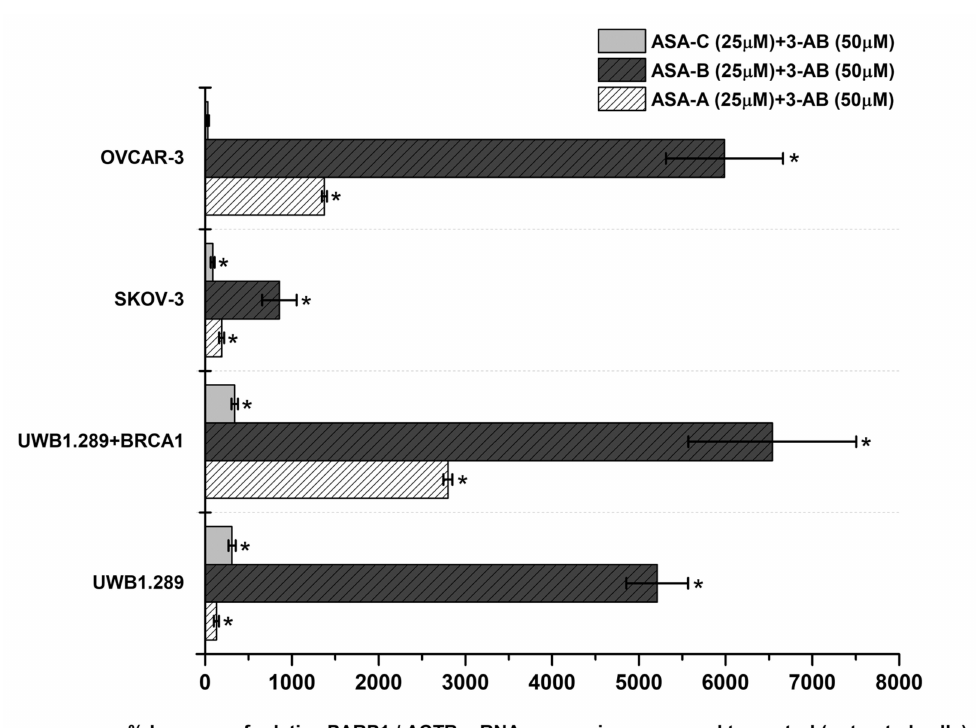
Figure 6. % Increase of the relative PARP1/ACTB mRNA cellular content ( ± Standard Error, SE) as compared to the corresponding control values (untreated cells) induced by the treatment of UWB1.289, UWB1.289 + BRCA1, SKOV-3 and OVCAR-3 human ovarian cancer cells with the combination of ASA-A, ASA-B or ASA-C at 25 µ M concentration along with 3-AB at 50 µ M concentration for 72 h. (*) Statistical significance for p < 0.001 (two-tail paired t